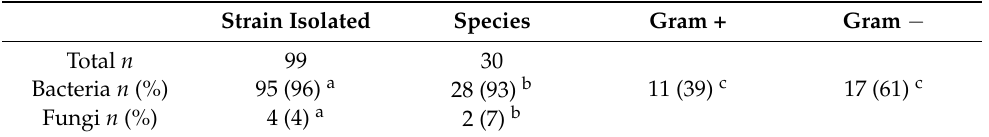
Table 4. DFUs and microorganism distribution.